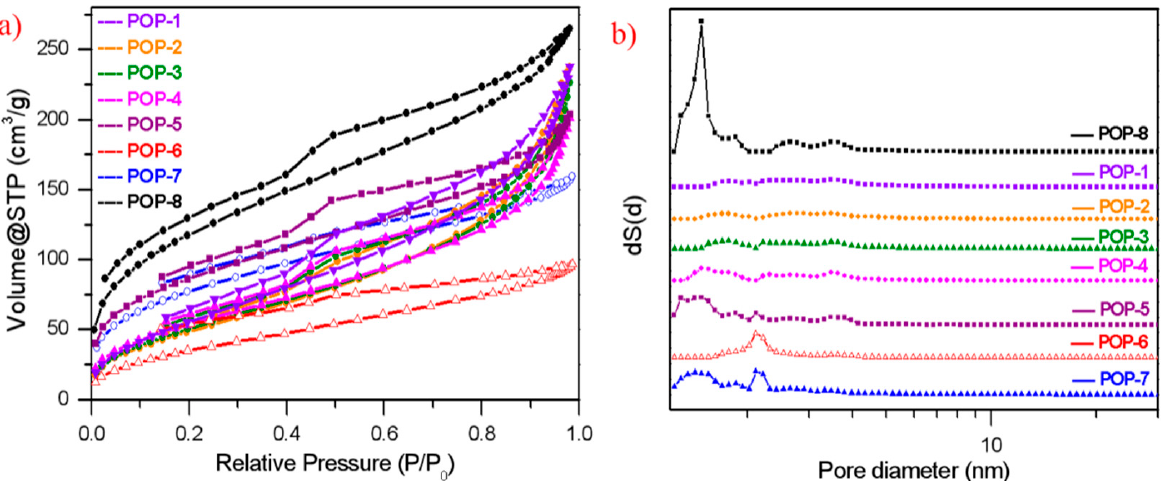
Figure 2. ( a ) N 2 isotherms, ( b ) non-local density functional theory (NLDFT) pore size distribution curves of the prepared TiO 2/POPs.